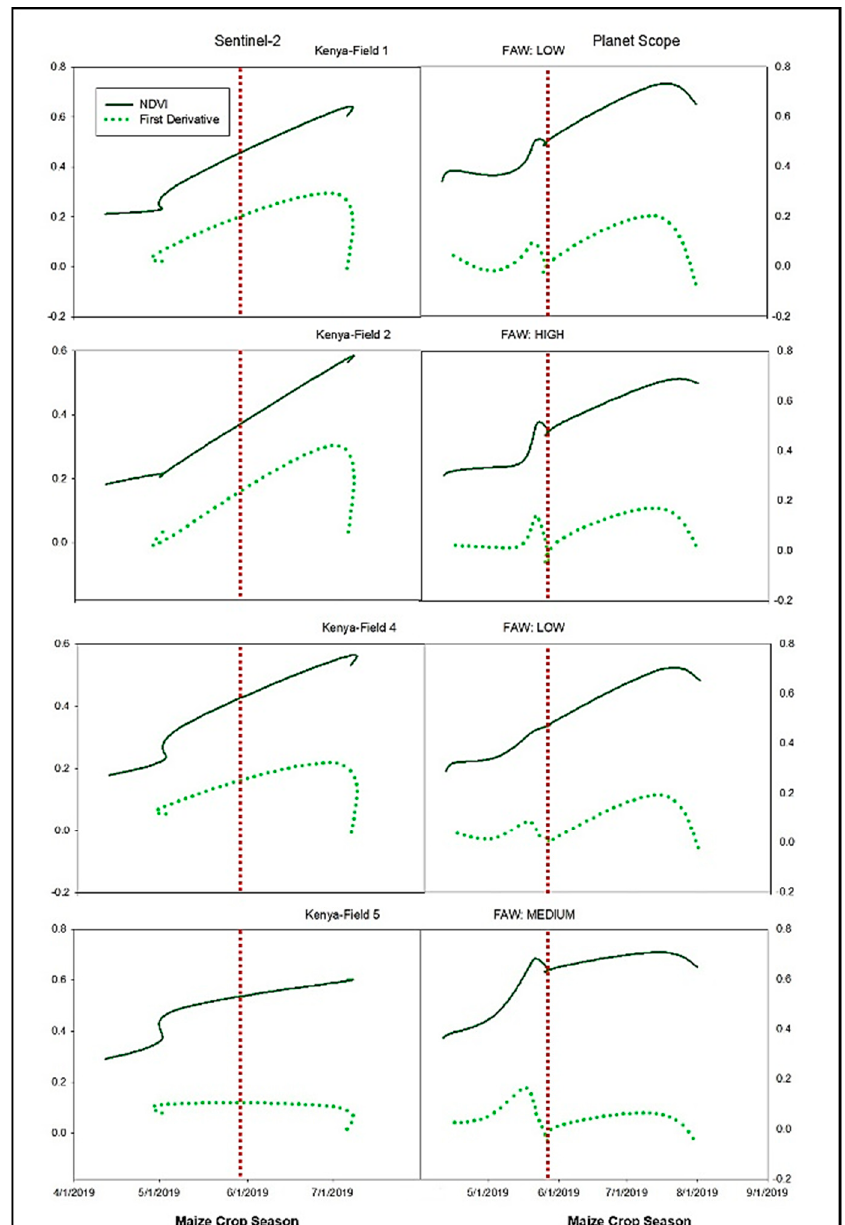
Figure 9. NDVI curves of vegetation from Kenya (continue green line) and the first derivative of NDVI curves (dashed light green line) were taken from Sentinel 2 a+b ( left ) and PlanetScope ( right ) along the first season of maize from the end of April to the end of July. The field presented three levels of infestations: LOW, MEDIUM, and HIGH. The vertical red dotted line is the day that we were in the field taking the data (28 May 2019). The x-axis ( left ) values between 0 and 0.8 belong to the NDVI index and x-axis ( right ) values between -0.2 and 0.8 belong to the NDVI first derivative. The Y axis belongs to the maize crop season from the sowing day to the harvest